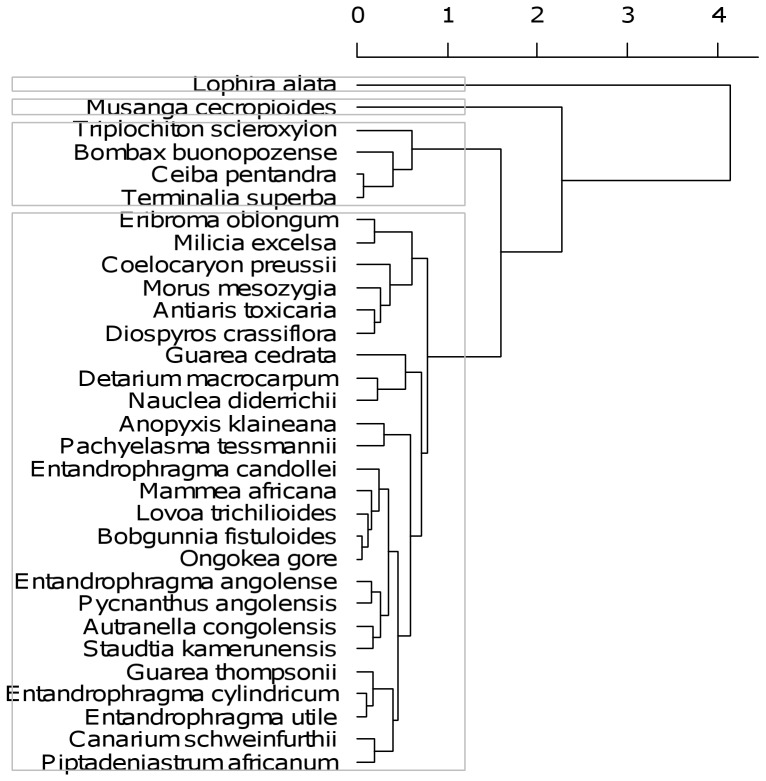
Cluster dendrogram grouping species with similar distribution patterns.A hierarchical cluster analysis on the Euclidean distances between species scores and an average agglomeration method was used to identify groups of species according to their distribution patterns, i.e. position across the compositional axes. The grey boxes indicate the cut-off level used to identify the four groups.